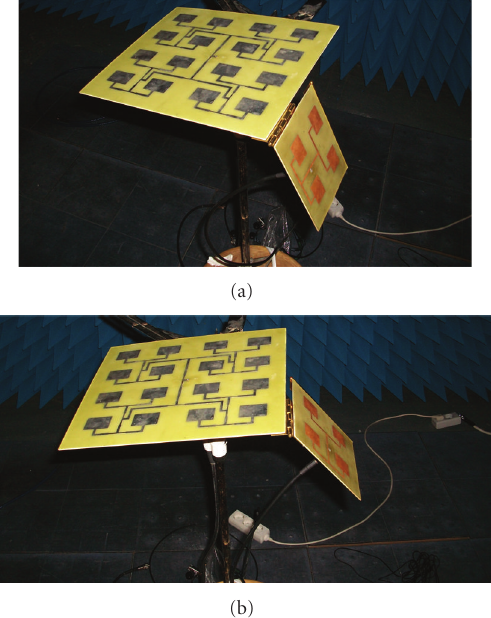
Figure 9: Access and backhaul antenna setup during coupling measurements.